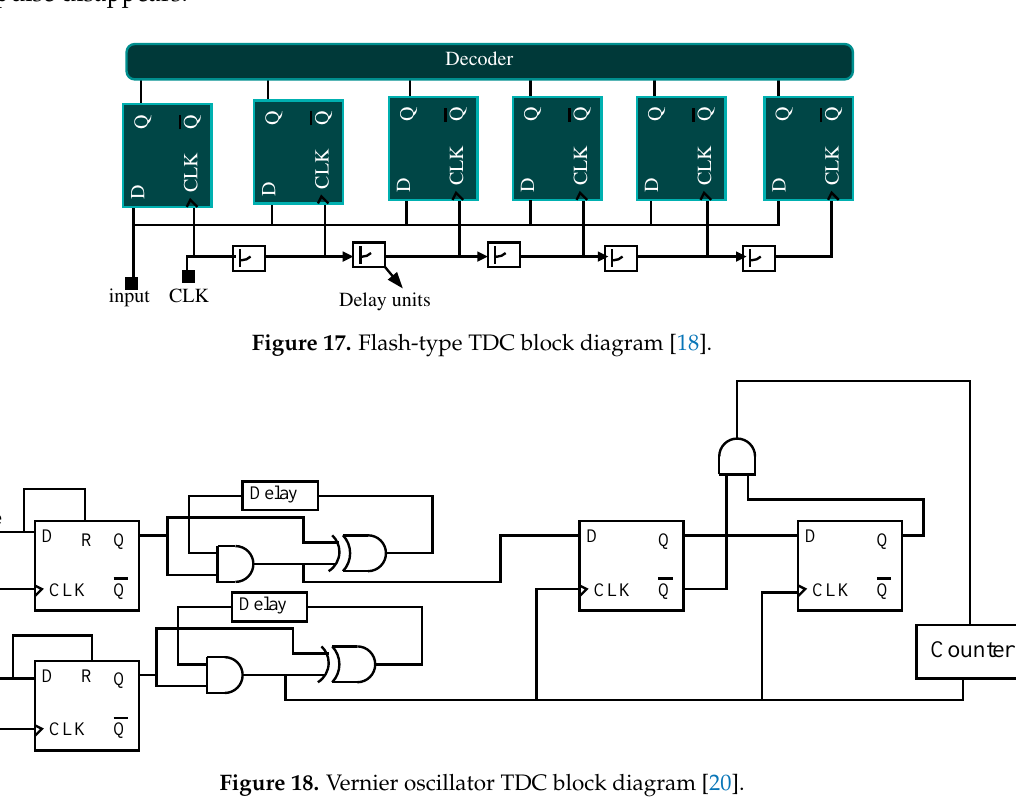
Figure 18. Vernier oscillator TDC block diagram [20].